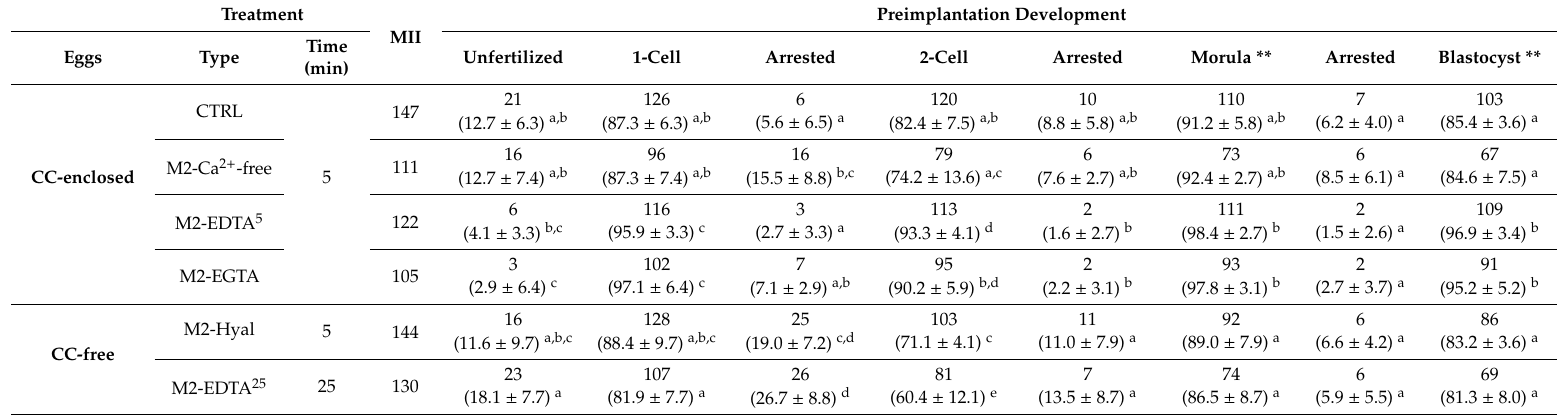
Table 1. Number (mean % ± s.d.) * of cumulus cells (CC)-enclosed and CC-free eggs that, after fertilization, developed to blastocyst or of embryos that blocked development during the passage from a stage to the next. Treatment Preimplantation MII